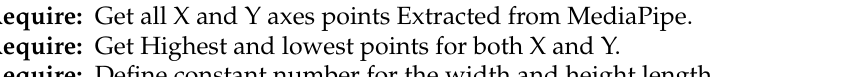
Algorithm 2 Scale Algorithm